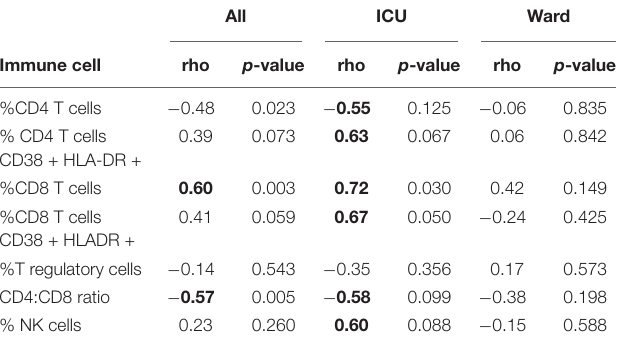
TABLE 2 | Correlations with% G-MDSC in children with acute COVID.